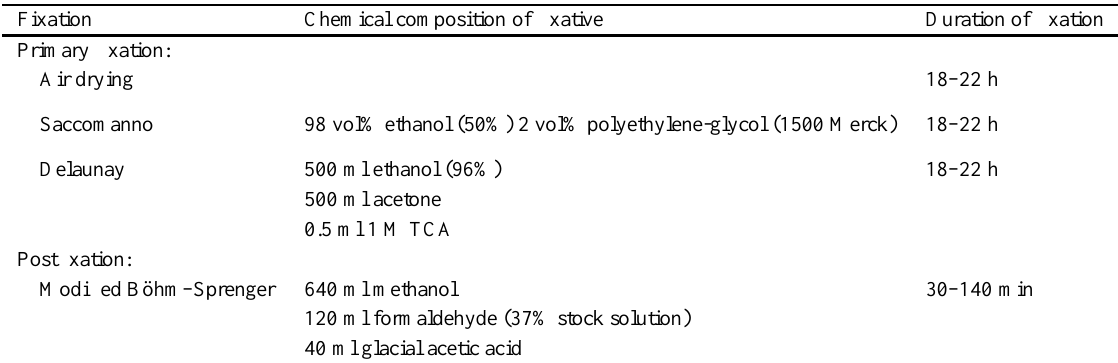
Chemical composition of fixatives and duration of fixation in different fixation techniques Fixation Chemical composition of fixative Duration of fixation Primary